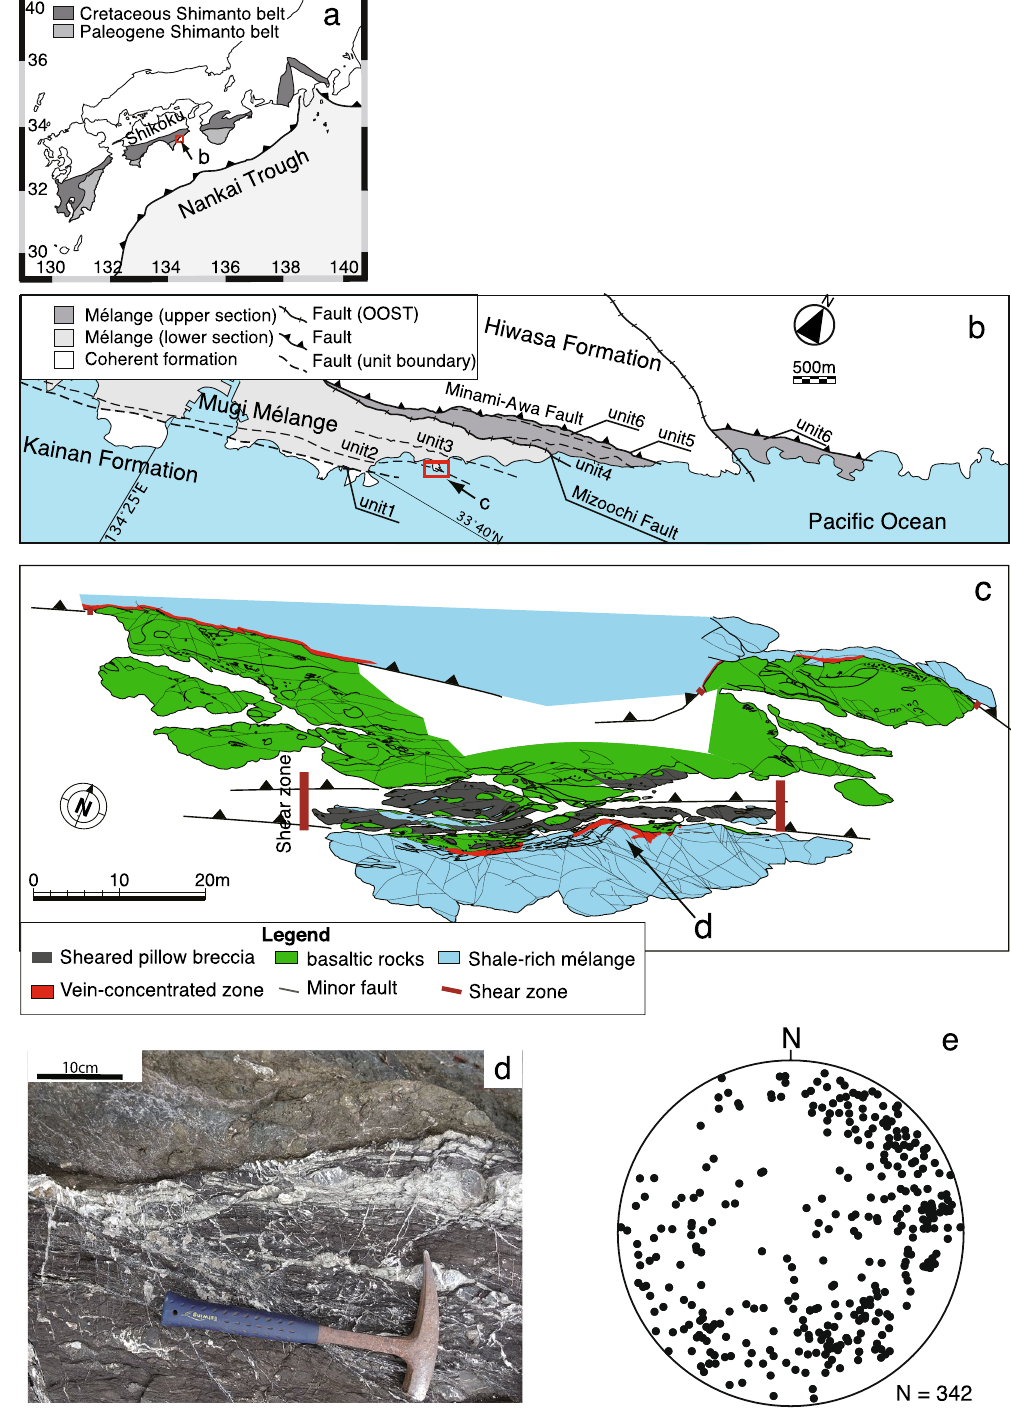
Figure 1. Geological setting of the study area. ( a ) Distribution of the Shimanto Belt in southwest Japan. ( b ) A regional geological map of the Mugi mélange, the Shimanto Belt modified from a previous study 20 . Upper and lower sections are divided by the Mizouchi Fault. The location of ( b ) is shown by an arrow in ( a , c ) A geological map of the study area modified from a previous study 14 . The shear zone is represented by vertical thick lines. The distribution of the network veins is indicated by the red area just south of the shear zone within the mélange. The location of the ( c ) is shown in ( b ) with an arrow. ( d ) A photograph of the network of the extensional veins. The location of the photograph is shown in ( c ) with an arrow. ( e ) The poles of the extensional veins plotted in a lower semi-sphere equal area stereonet. Maps ( a – c ) were created by Adobe Illustrator 26.3.1 (https:// www. adobe. com/ jp/ produ cts/ illus trator.